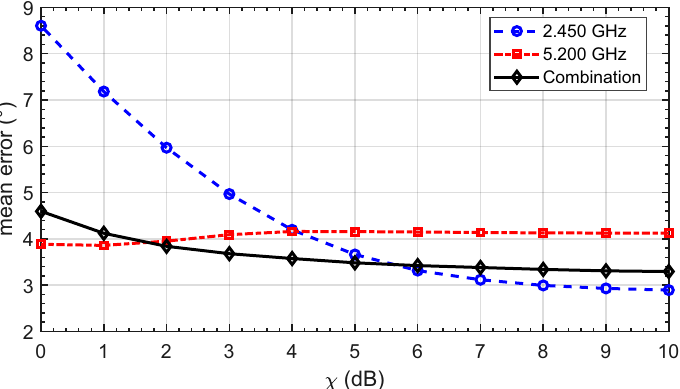
Figure 9. Mean DoA estimation error for D = 2m.